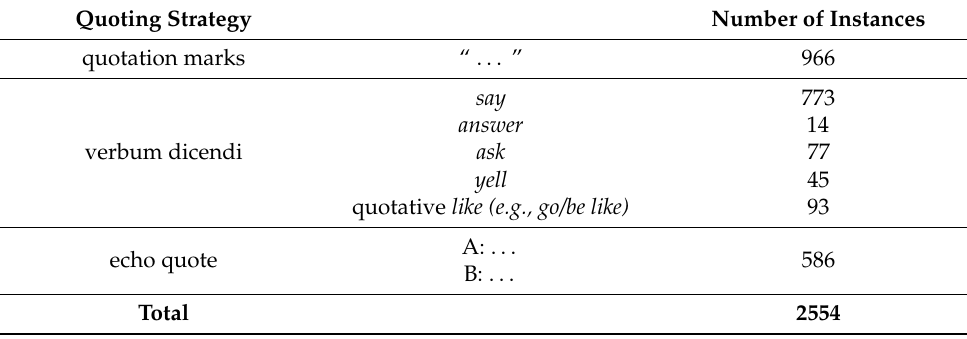
Table 3. Types and Instances of Quoting in Code-Switched Comments.